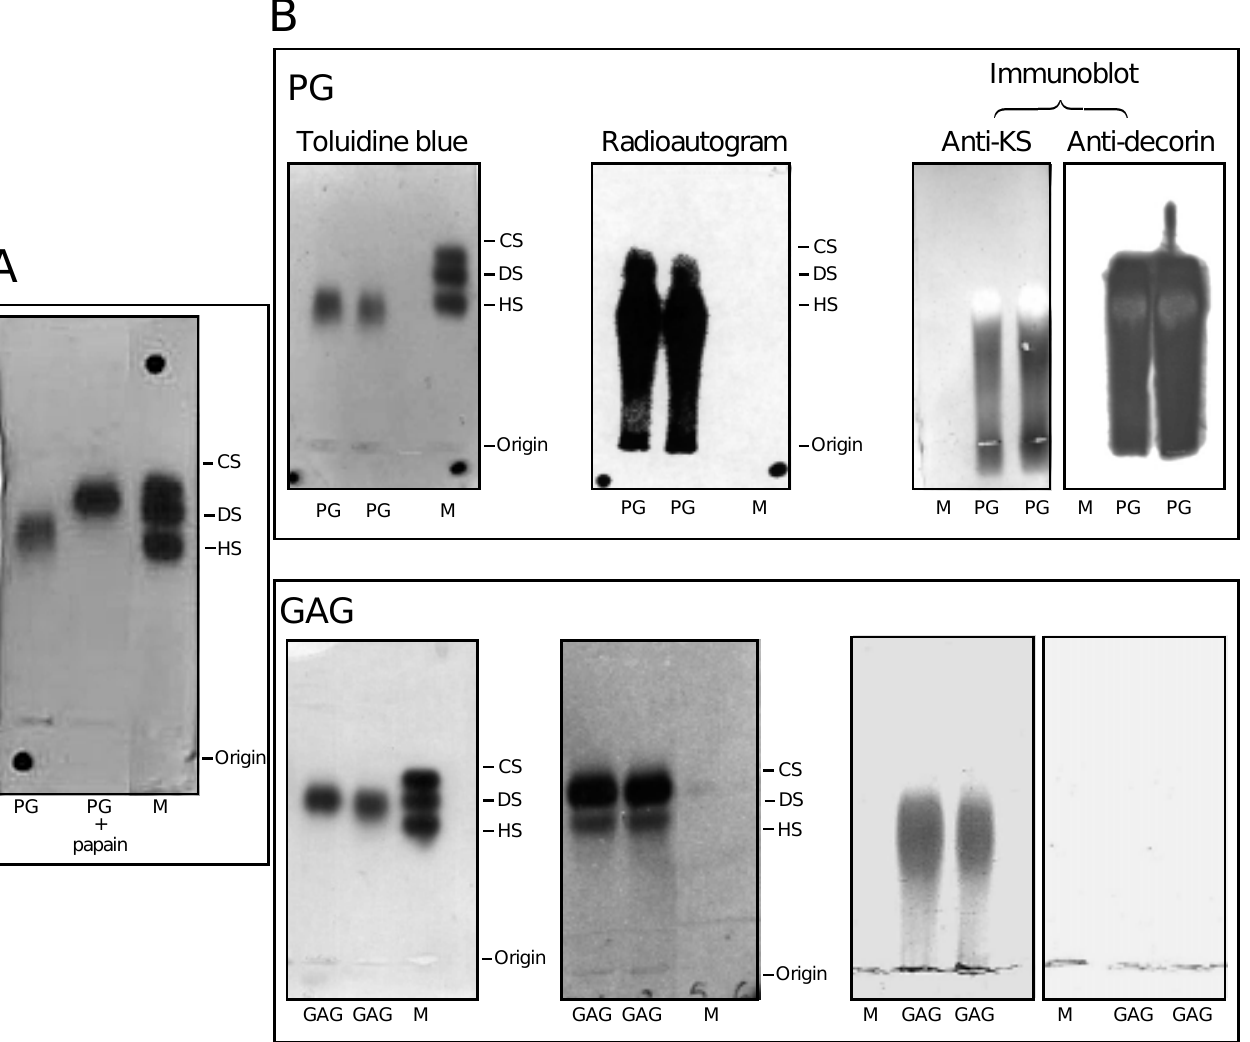
Figure 1 - Agarose gel electrophoresis of proteoglycans and glycosaminoglycans extracted from human corneas. Aliquots (5 µl) of papain-digested proteoglycans (panel A), or intact proteoglycans (PG) and glycosaminoglycans (GAG) (panel B) extracted from human corneas were submitted to agarose gel electrophoresis in 0.05 M 1,3-diaminopropane acetate buffer, pH 9.0, at 5 V/cm for 1 h. The proteoglycans and glycosaminoglycans were fixed in the gel by 0.1% cetyltrimethylammonium bromide and stained with toluidine blue, as previously described (15). The 35 S-labeled compounds were observed by radioautography. Decorin (a dermatan sulfate proteoglycan) and keratan sulfate were also identified by immunoblotting stained with an anti-decorin polyclonal antibody and MST1 (an anti-keratan sulfate monoclonal antibody). M: Mixture of standard glycosaminoglycans containing chondroitin sulfate (CS), dermatan sulfate (DS), keratan sulfate (KS), and heparan